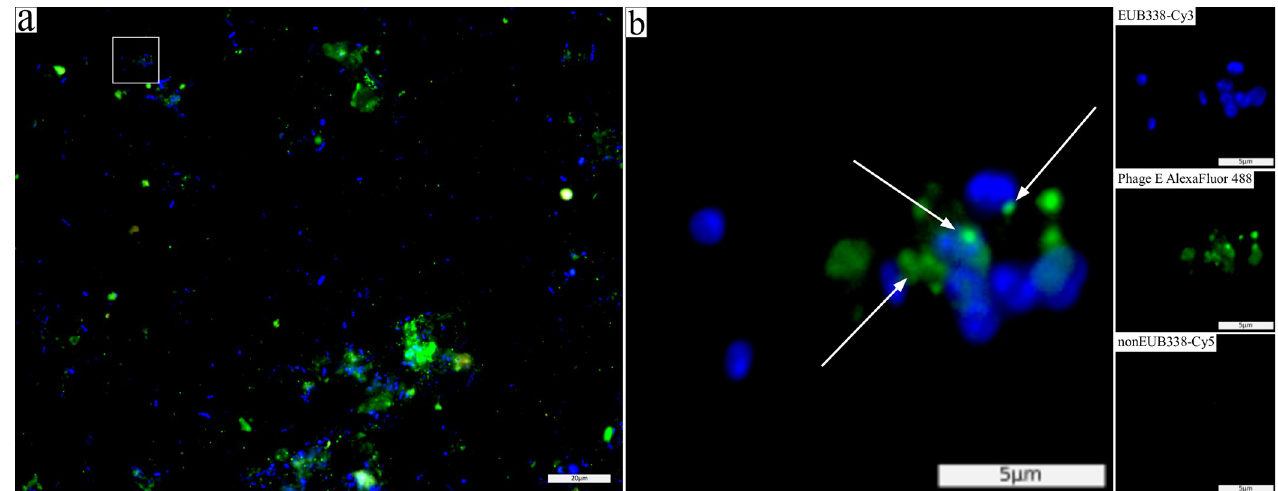
Fig 3. Co-localisation of phage signals and EUB338-Cy3 signals allows visualisation of phage-host interaction and phage behaviour. Microscopic image of faecal smear (sample F49) hybridised with phage group E probes (green), universal bacterial probe EUB338-Cy3 (blue), and non-specific probe nonEUB338-Cy5 (red). Various loci of phages were observed within or around the bacterial cells (white arrows in b). For example, phages exist as free-floating phages visible as single signals not co-localised to any bacterial signal, or adsorbed to the outer membrane of the host cell. White box in (a) indicates enlarged area in (b). Panels to the right show separated signals (EUB338-Cy3, Phage probe E, and nonEUB338-Cy5) of the enlarged area. Scale bars indicate 20 μ m (a) and 5 μ m (b).